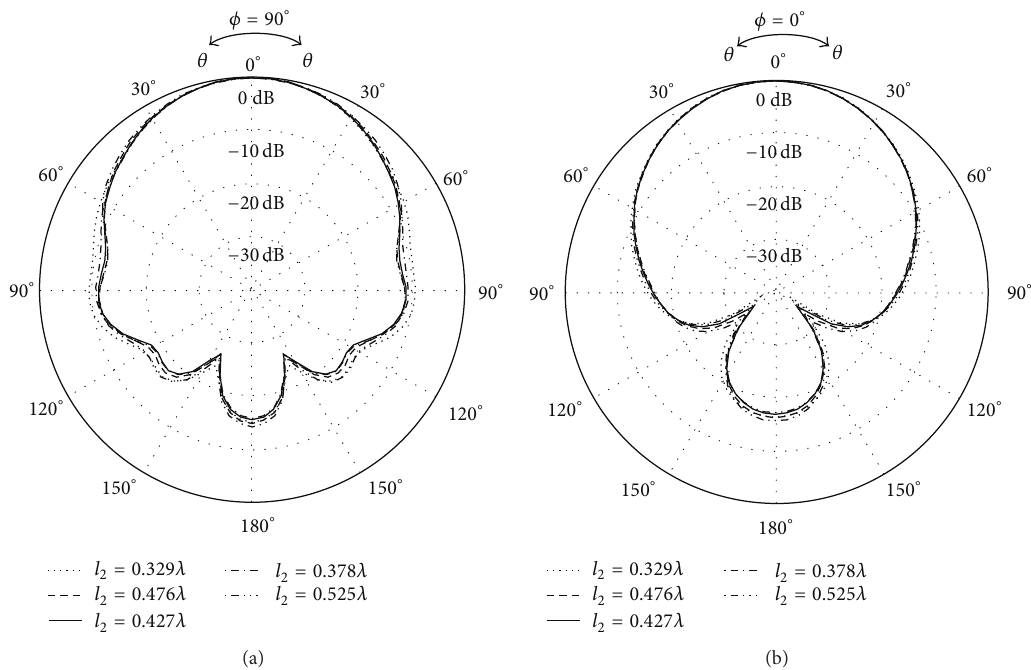
Figure 17: Simulated radiation patterns for various parasitic coupling aperture lengths ( 𝑙 2 ) at the lower frequency of 2.45 GHz in (a) the 𝐸 -plane and (b) the 𝐻 -plane.